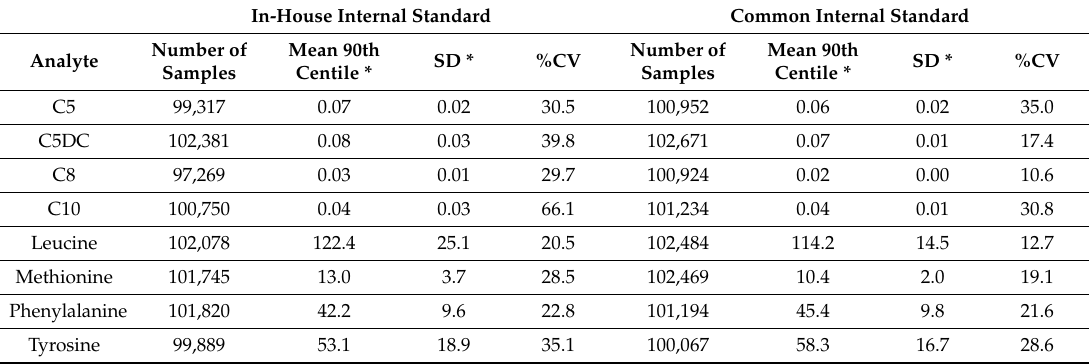
Table 1. Summary of the mean, relative standard deviation and co-e ffi cient of variation at the 90th centile for each analyte, measured with the individual laboratories in-house internal standard (IS) and with the common IS